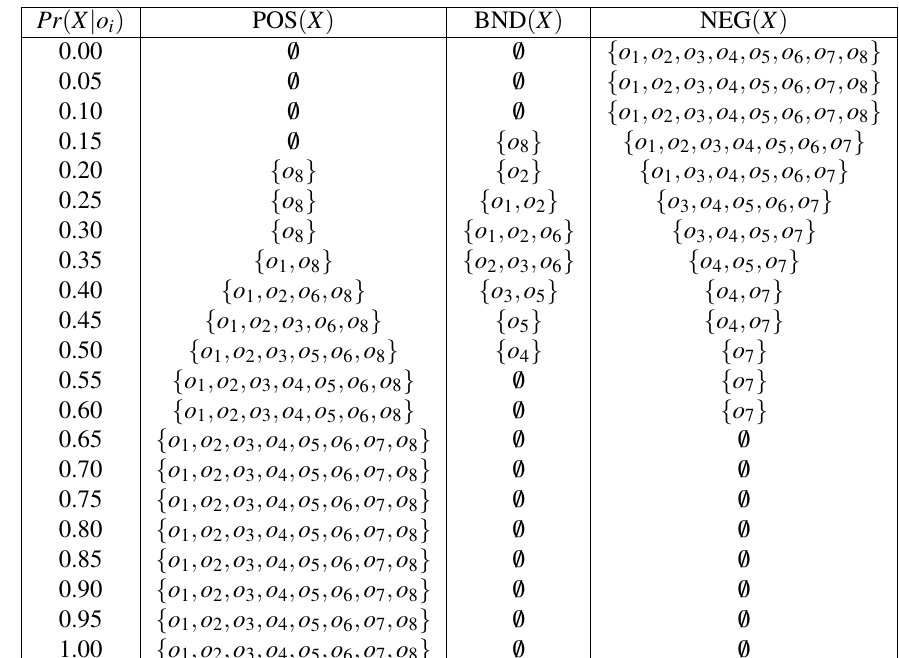
Table 3. The decision rules when the conditional probability